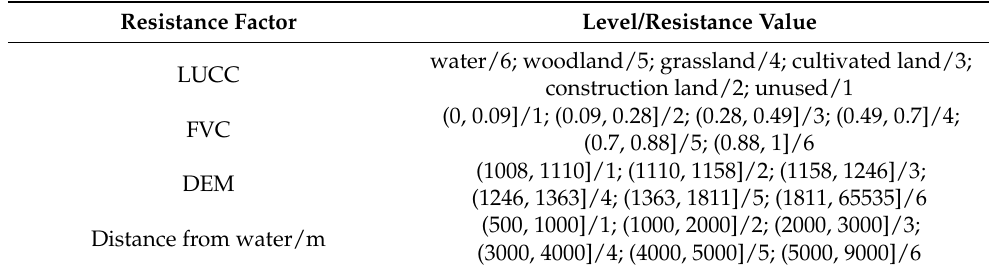
Table 4. Division of the single-factor resistance